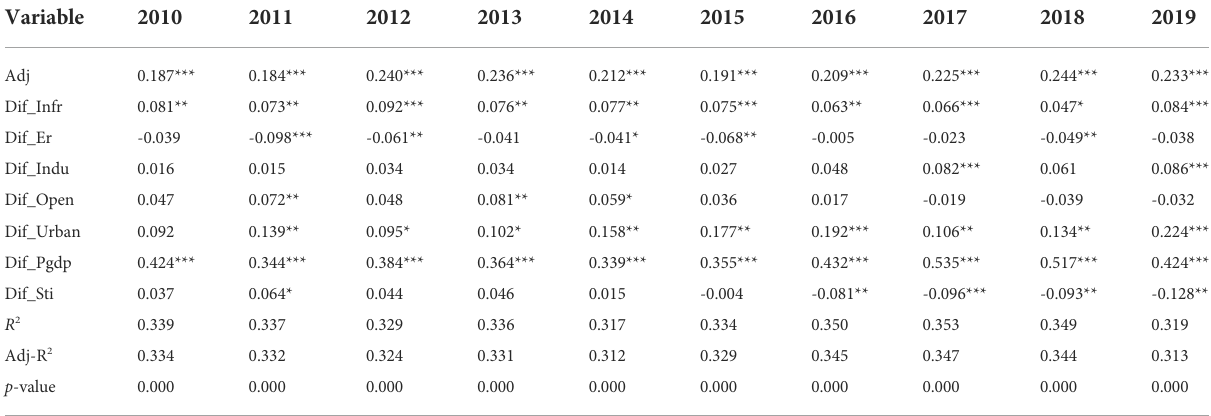
TABLE 9 Results of QAP regression analysis (2010 – 2019).